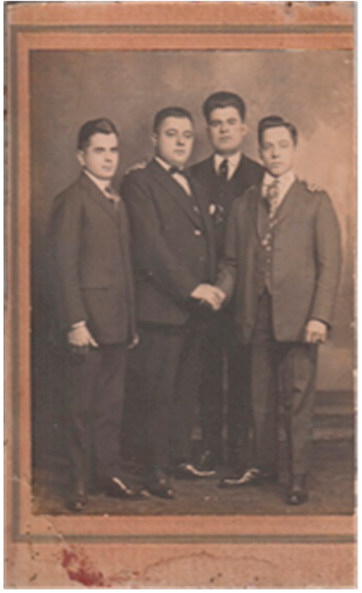
Figure 5. Giorgos, Antonis, friends and kin handshake (author’s collection).